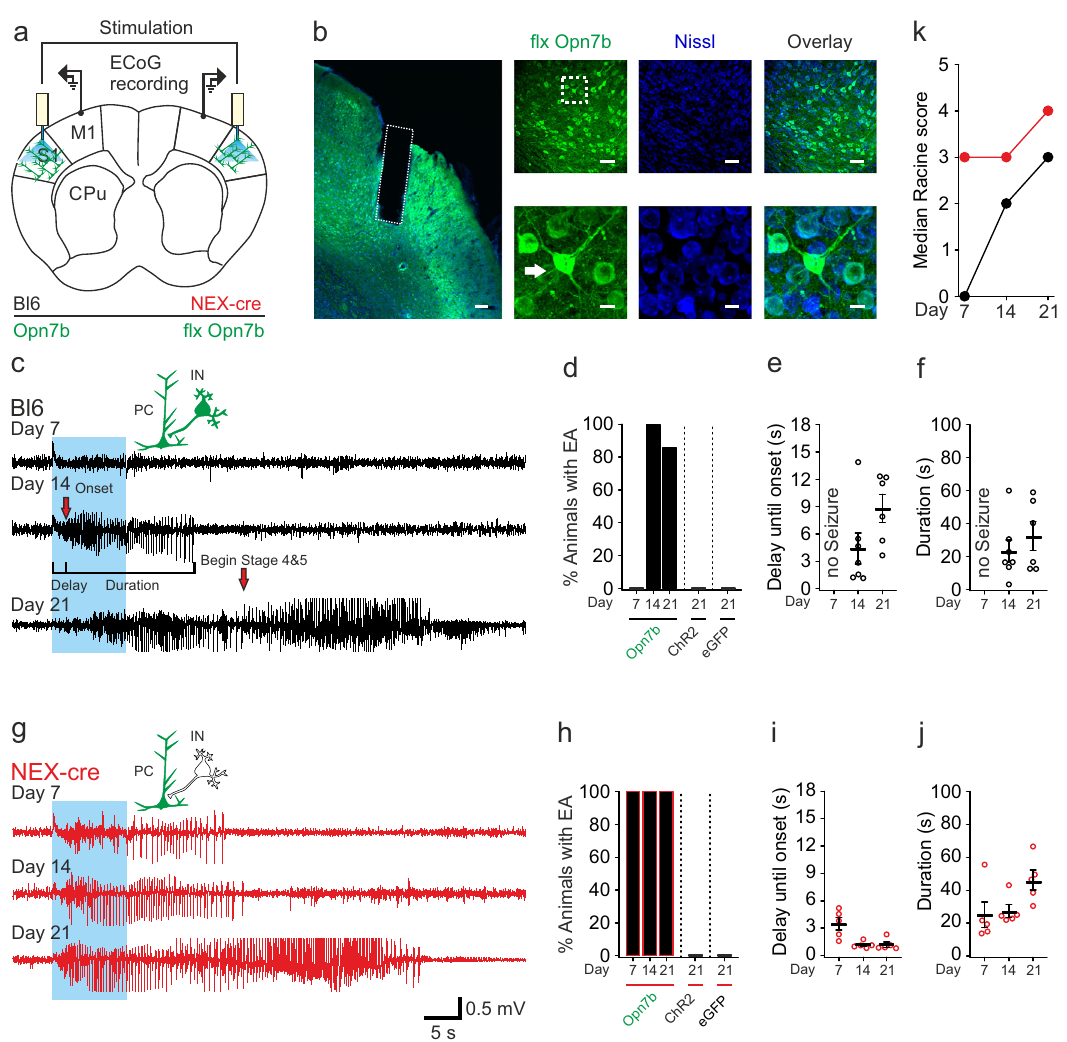
Fig. 4 Light-mediated deactivation of Opn7b in primary somatosensory cortex induces epileptiform activity in mice. a Schematic description of the bilateral electrocorticographic (ECoG) recording in M1. For simultaneous light stimulation, bilateral optic fi bers were implanted in the primary somatosensory cortex (S1) after viral injection. Primary motor cortex (M1); Caudate putamen (CPu). b Representative example of fl oxed ( fl x) Opn7b (green) expression in S1 and general neuronal staining (Nissl, blue) in NEX-cre mice. The dashed box in the left panel represents the fi ber tract of the implanted fi ber. Scale bar 100 µ m. The dashed box in the right top panel is a zoom of a single neuron and its axon (arrow) in the bottom panel. Scale bar 50 µ m top panel and 10 µ m bottom panel. c Bl6 mice (black trace) and ( g ) NEX-cre mice (red trace) were recorded weekly and stimulated with 10 s blue light (465 nm, blue box). c First epileptiform activities (EAs) were detectable on day 14 after virus injection following stimulation in Bl6 mice expressing Opn7b and ( g ) on day 7 in NEX-cre mice in ECoG recordings and video recordings. Pyramidal cell (PC); Interneuron (IN). d Bars represent the percentage of Bl6 mice ( n = 7 animals) and ( h ) NEX-cre ( n = 5 animals) mice that developed EA after light stimulation. None of the Bl6 controls expressing channelrhodopsin-2 (ChR2, n = 3 animals) or enhanced green fl uorescent protein (eGFP, n = 5 animals) showed pathological ECoG changes upon light stimulation. NEX-cre mice developed EA on every recording day following fl oxed Opn7b stimulation, while none of the NEX-cre fl oxed ChR2 ( n = 3 animals) or fl oxed eGFP mice ( n = 8 animals) developed EA upon light stimulation. e , i The delay until onset of EA was measured at the time between stimulation onset and the beginning of ECoG EA (see c). Bl6 day 14 n = 7, day 21 n = 6 and Nex-cre day 7 – 21 n = 5. f , j The EA lasted around 30 s for Bl6 and NEX-cre mice. Bl6 day 14 n = 7, day 21 n = 6 and Nex-cre day 7 – 21 n = 5. k The severity of EA was measured as the median value of the modi fi ed Racine scale which was higher on day 7 in NEX-cre mice than in Bl6 mice. Bl6 day 7 – 21 n = 7 and Nex-cre day 7 – 21 n = 5. Each circle represents individual EA, while the bar represents the mean value for all animals. Error bars represented as ±SEM. Source data are provided as a Source Data fi